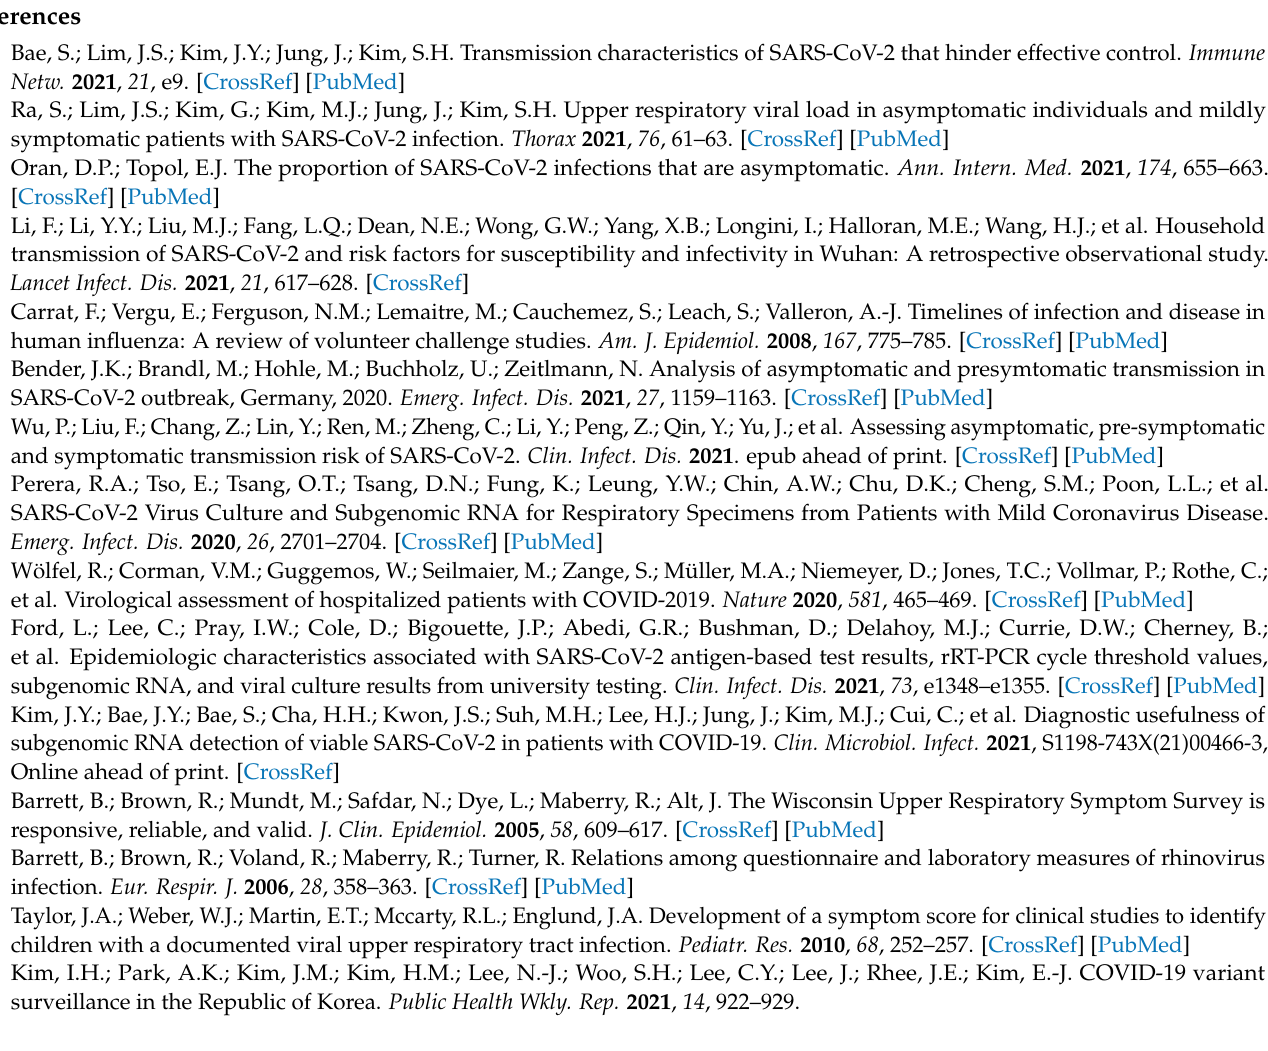
from symptom onset. B. Days from diagnosis, Figure S3: Correlation analysis between symptom score and viral load. Black line indicates linear regression line, and grey shadow indicates the 95% confidence interval, Figure S4: Correlation curves for cycle thresholds versus copies of the N and S